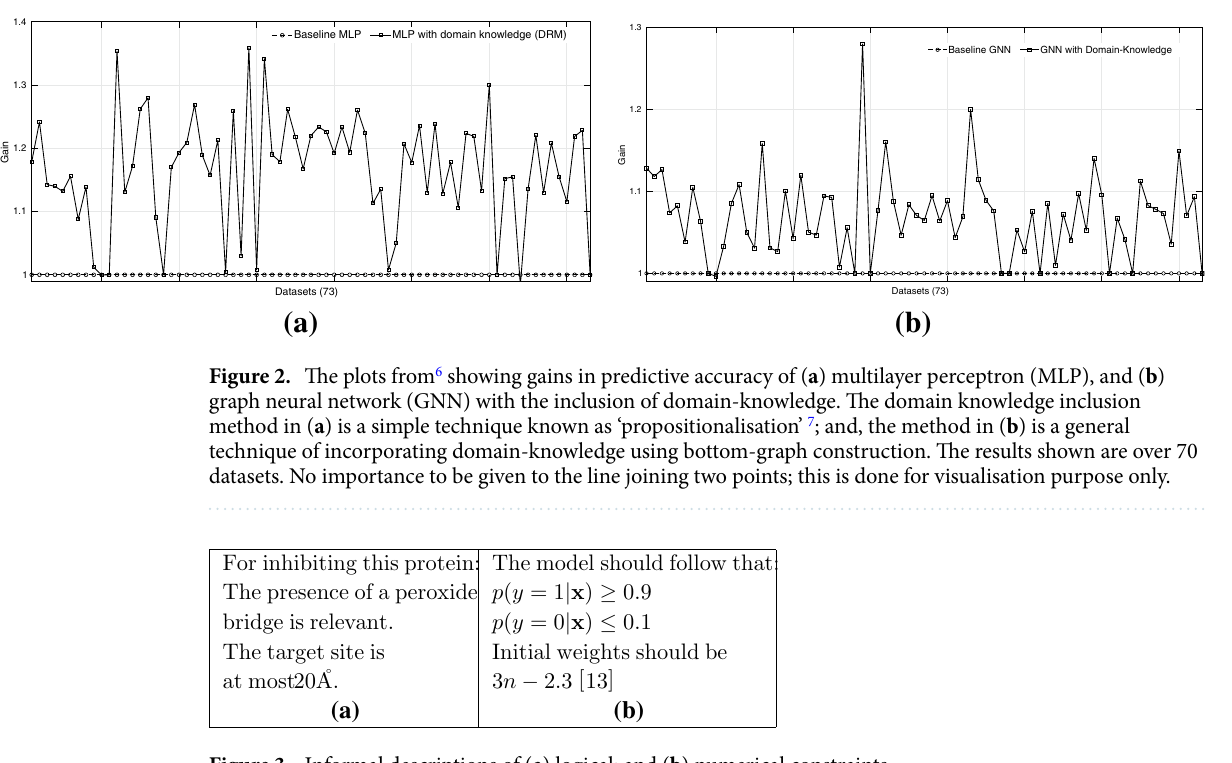
Figure 3. Informal descriptions of ( a ) logical; and ( b ) numerical